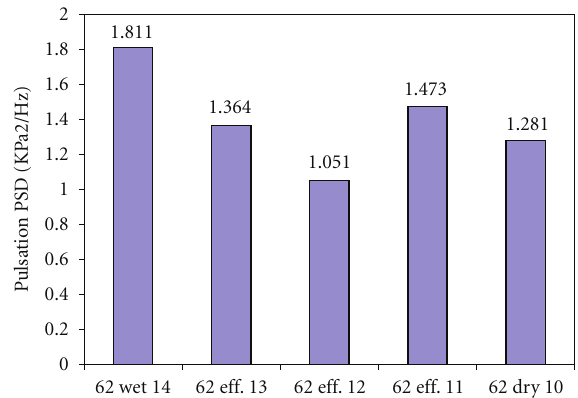
Figure 16: Comparison of peak pulsation energy for dry, wet, and e ff ervescent injection at 55000 RPM.